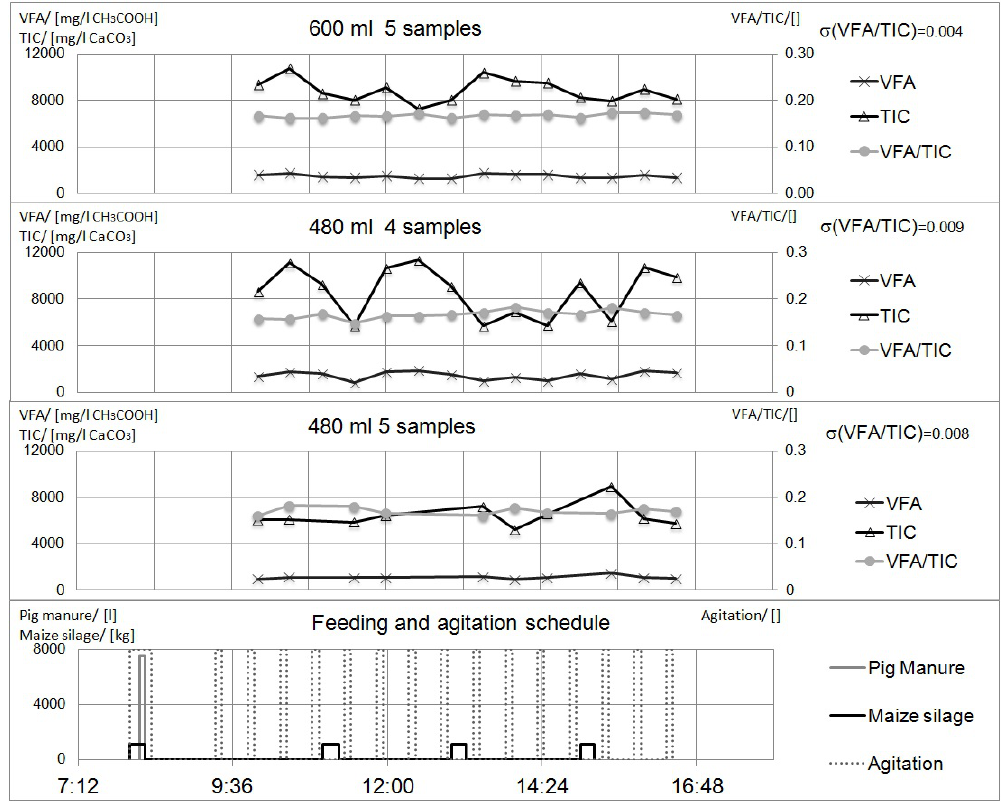
Figure 6. Configurations comparison. Lowest graphic presents corresponding feeding and agitation